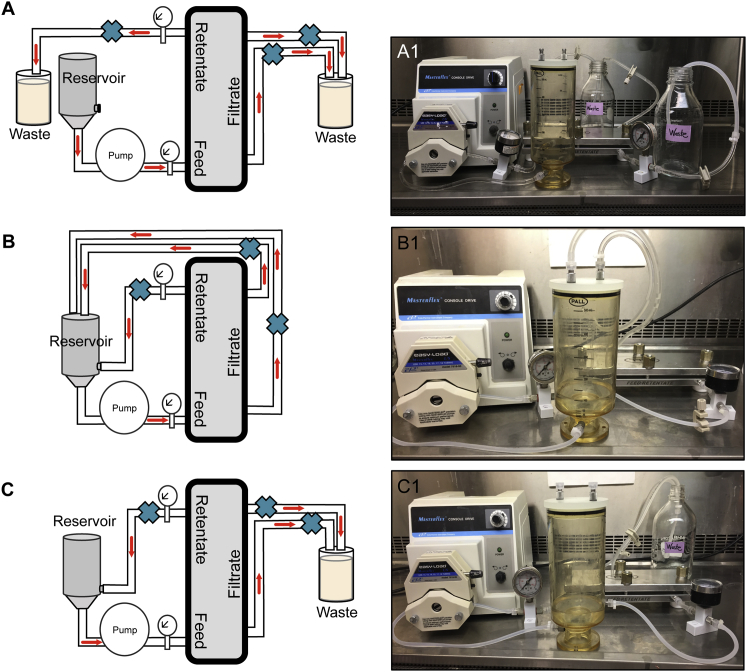
Schematic of the Three Different TFF Configurations Utilized for NDV Purification(A) Schematic of the TFF setup for flushing and cleaning the cassette and tubing. Note placement of pressure gauges. Labels on the side of the Centramate indicate where the feed/retentate and filtrate lines should be connected. (B) Setup for a closed circulating system. The filtrate and retentate lines go back to the reservoir. Blue crosses indicate where clamps can be attached. These clamps can be used to increase pressure during sanitation cycles. (C) Schematic of virus purification and concentration setup. Note the retentate containing the virus is circulating back into the reservoir, whereas the filtrate line ends up in a waste container.